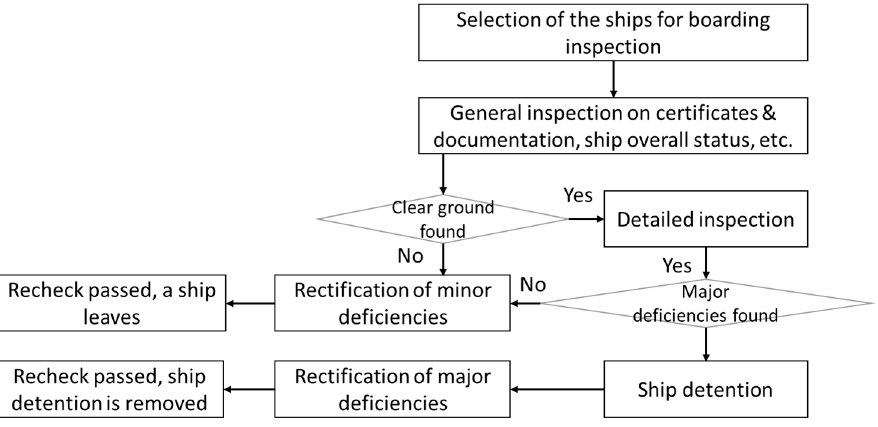
Figure 1. Port state control (PSC) inspection workflow.